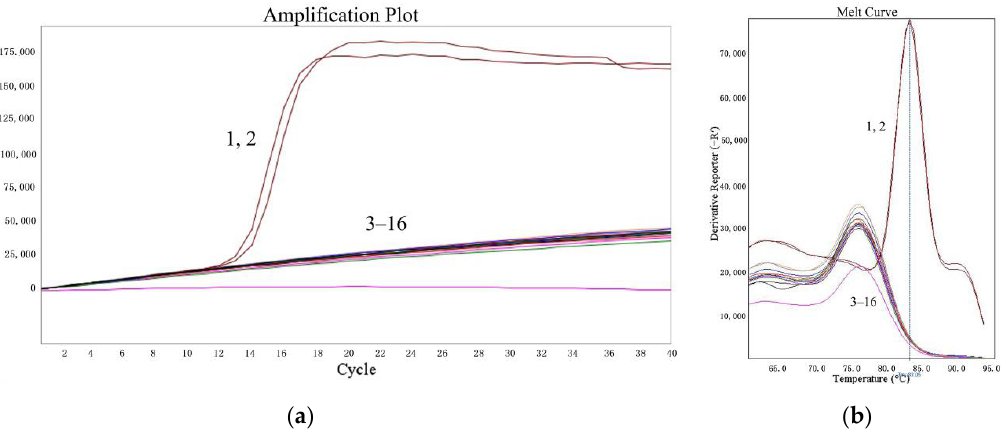
Figure 2. Specificity of the LMTIA assay with different DNA types. ( a ): the amplification plot of the LMTIA assay; ( b ): the melt curve of the LMTIA assay. 1, 2: cassava DNA; 3, 4: ddH 2 O; 5–16: the DNAs of I. batatas , S. tuberosum , Z. mays , V. radiata , T. aestivum , and G. max